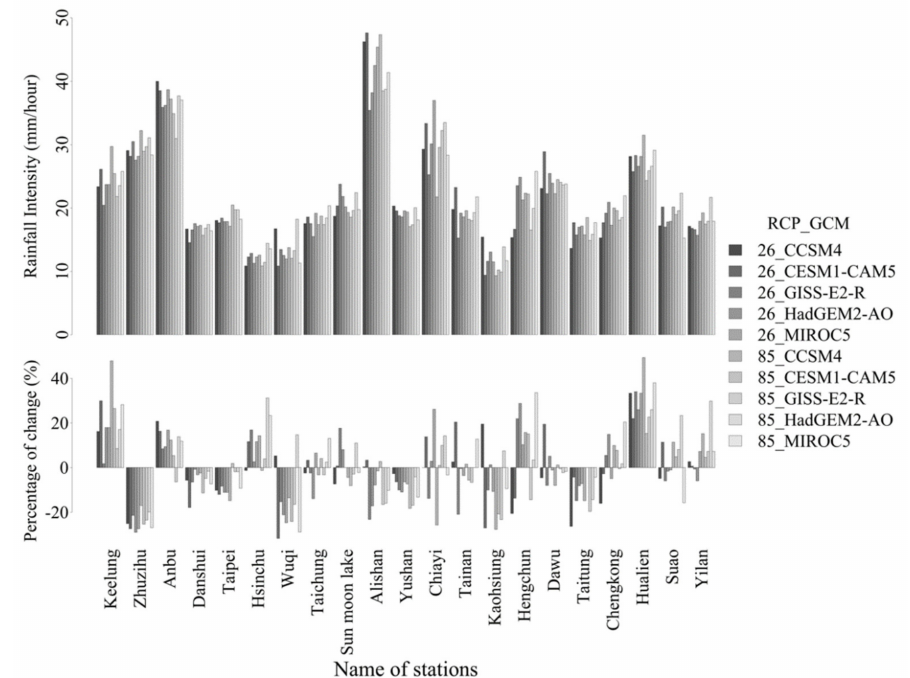
Figure 8. Rainfall intensities ( top ) and percentage of changes ( bottom ) of events with twenty-four-hour du-ration and twenty-five-year return period (events long ) for far future (2081–2100) under RCP2.6 and RCP 8.5 for five GCMs (CCSM4, CESM1-CAM5, GISS-E2-R, HadGEM2-AO,